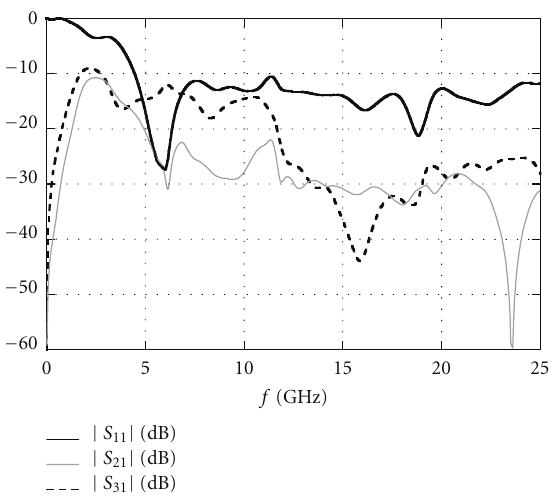
Figure 3: Antenna of Figure 1. Magnitude of the scattering coe ffi cients of the radiating element fed by the four probes. Reflection coe ffi cient | S 11 | at the input port 1 ( black line ) and transmission coe ffi cients | S 21 | from port 1 to port 2 ( gray line ) and from port 1 to port 3 ( dashed black line ).